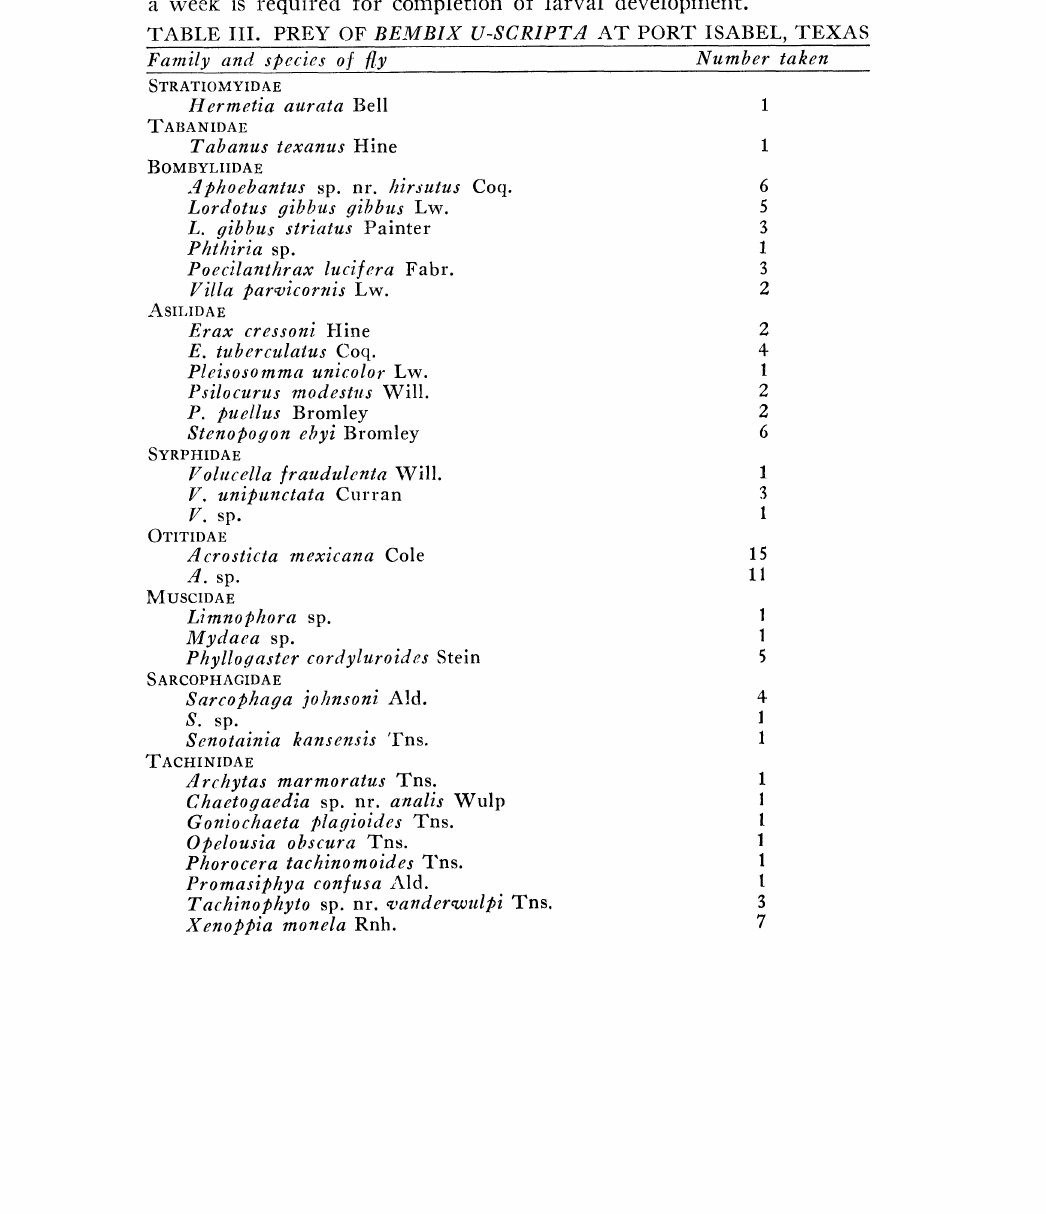
TABLE III. PREY OF BEMBIX U-SCRIPT/1 AT PORT ISABEL, TEXAS Family and species of tl,